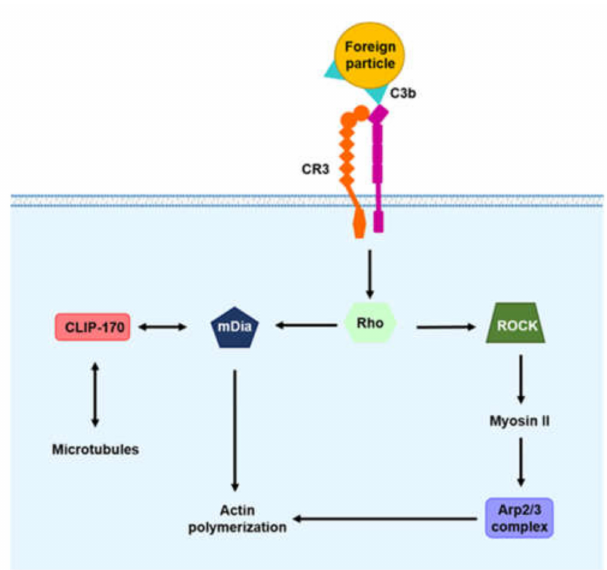
Figure 2. Complement receptor (CR)-mediated signaling for phagocytosis. CR binds to various complement components and initiates intracellular signaling cascades via Rho. Rho activates ROCK, and activated ROCK induces myosin II phosphorylation, and recruits the Arp2 / 3 complex, which leads to branched actin polymerization. Activated Rho also recruits mDia1, which mediates actin polymerization into a linear network. mDia also interacts directly with CLIP-170, which interacts with microtubules, to promote actin